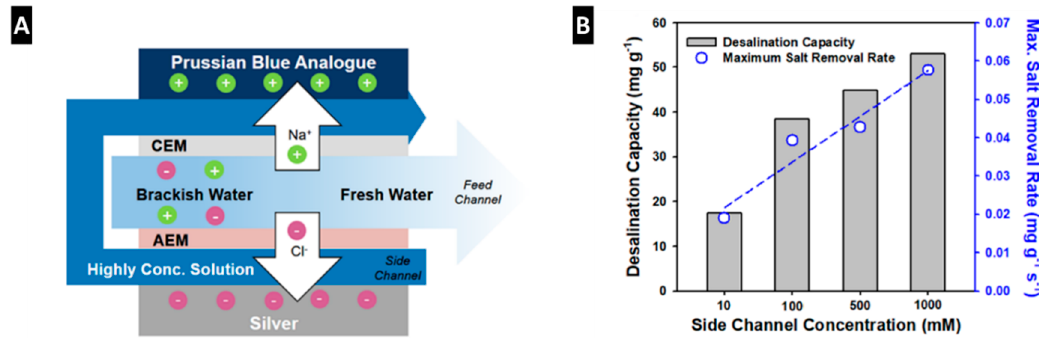
Figure 8. ( A ) Schematic illustration and ( B ) desalination capacity as well as the maximum salt removal rate of multichannel membrane CDI (MC-MCDI) using battery type electrodes (Reprinted with permission from [35]. Copyright (2019) American Chemical Society).